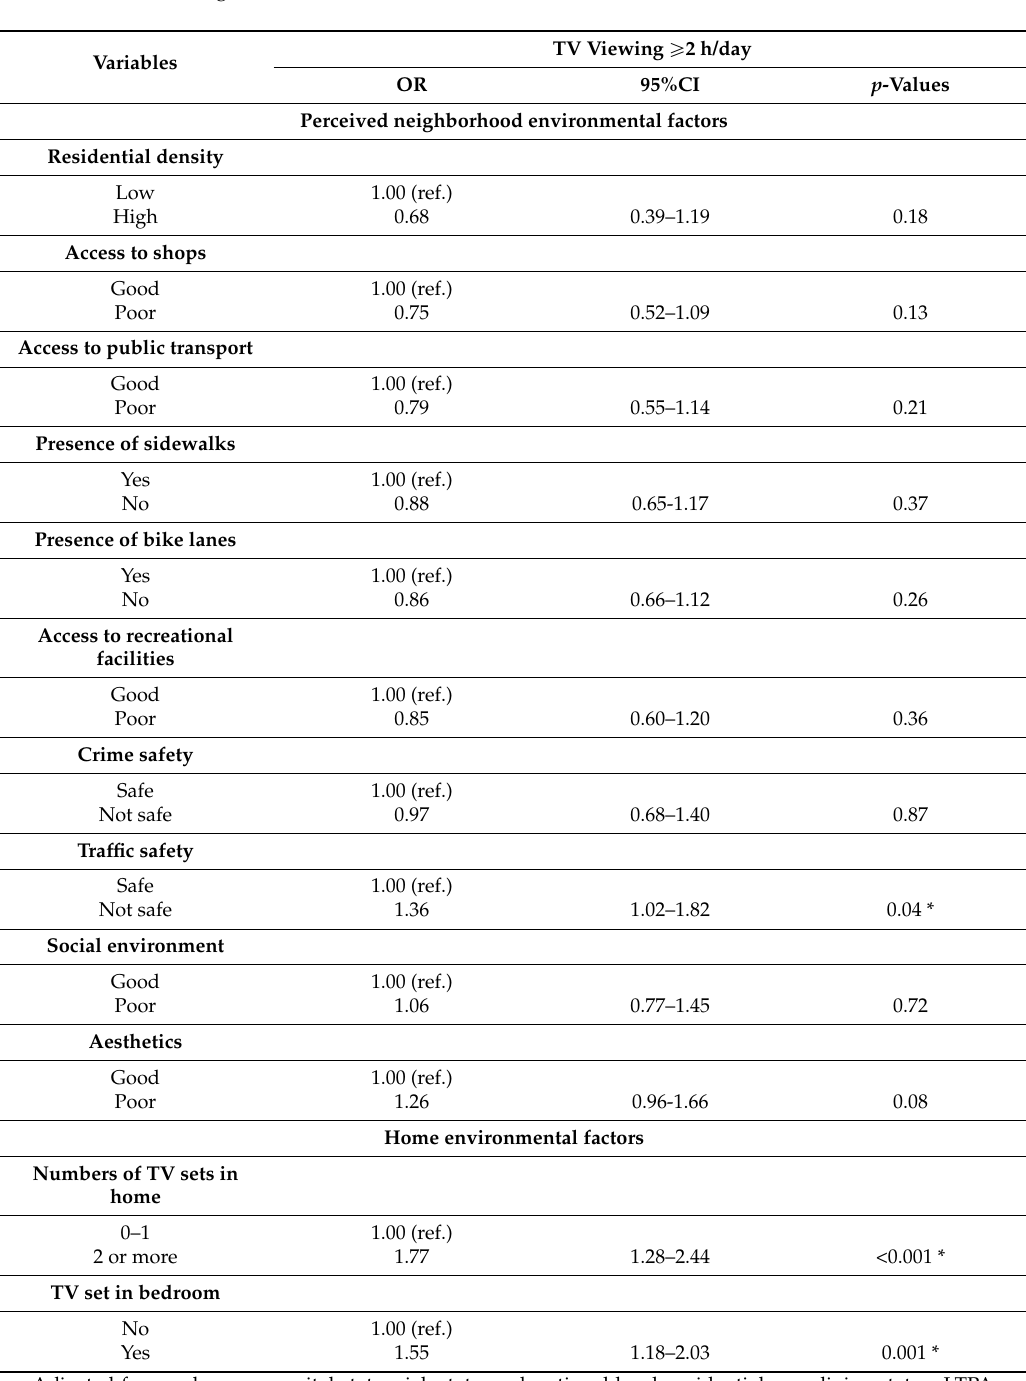
Table 4. Odds ratios for perceived neighborhood and home environmental variables and likelihood of excessive TV viewing